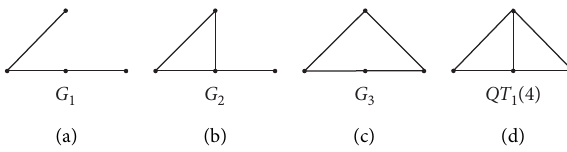
1 , G 2 , G 3 and QT 1 (4).